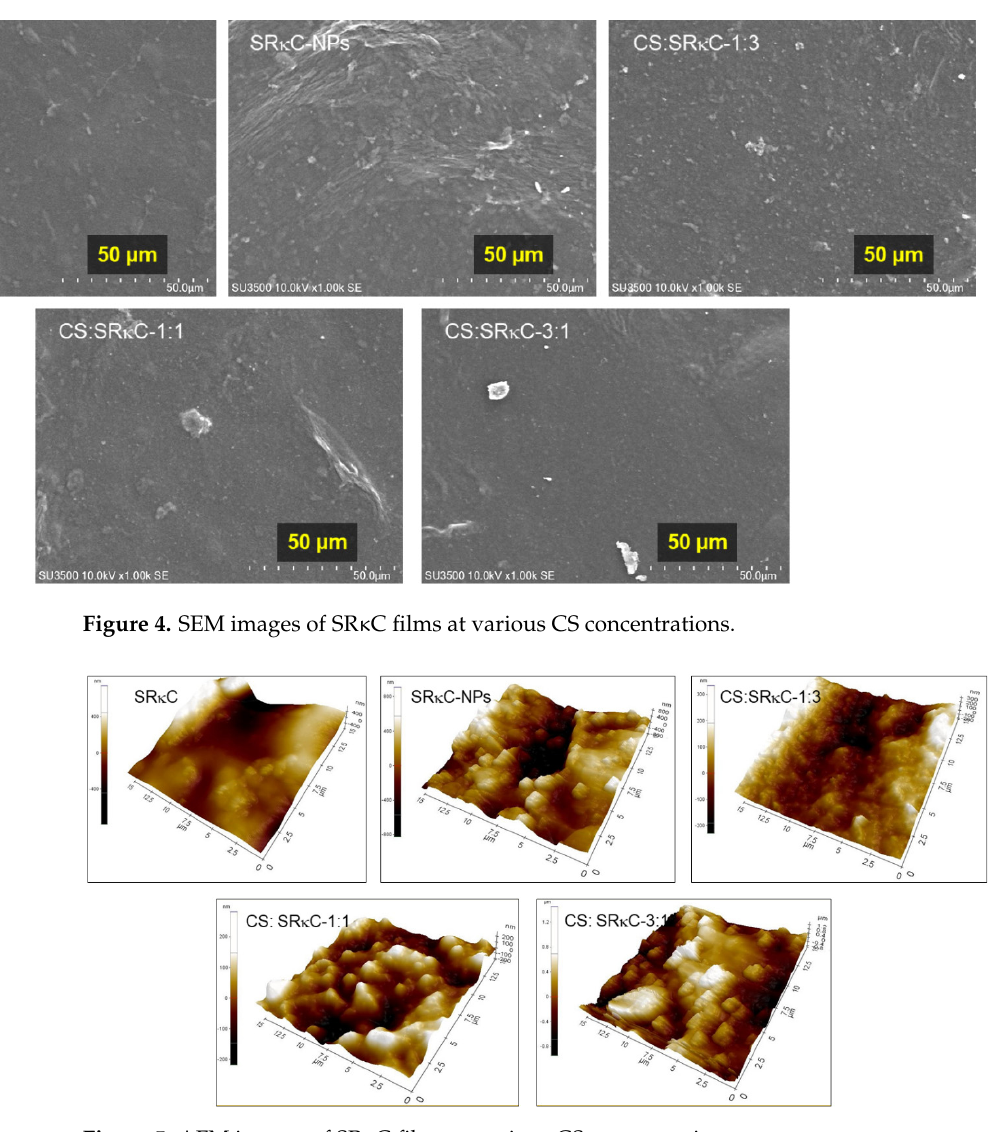
Figure 5. AFM images of SR κ C films at various CS concentrations.